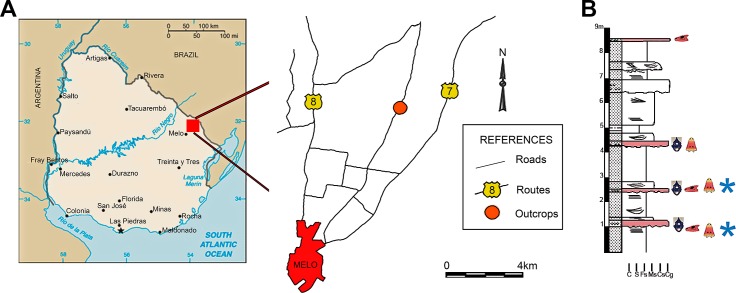
Maps showing the locality that yielded the archosauromorph remains described here (A) and stratigraphic column of the Buena Vista Formation as it outcrops in the locality indicating the archosauromorph-bearing levels with an asterisk (B).Modified from Piñeiro, Ramos & Marsicano (2012).